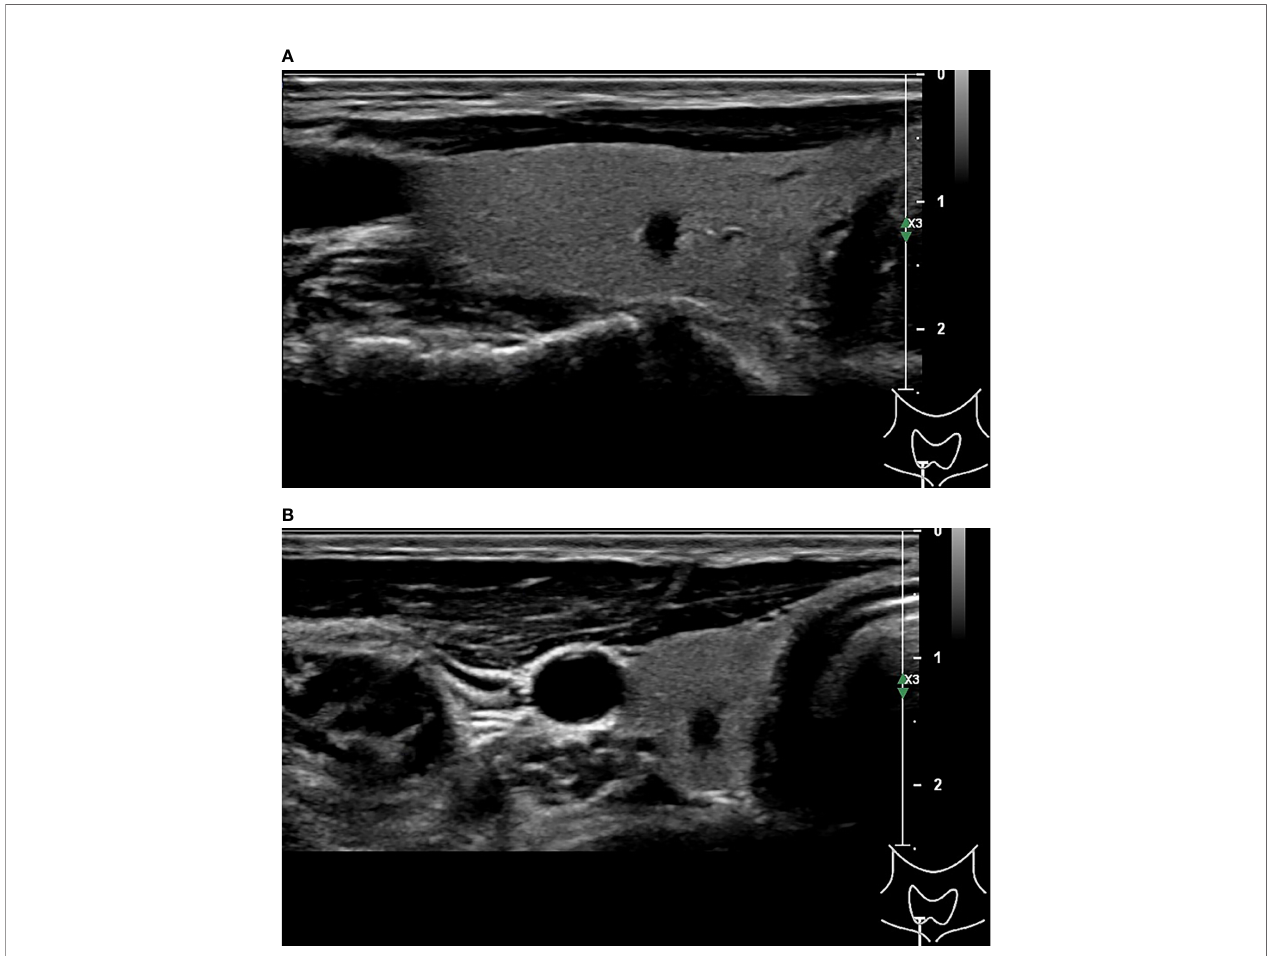
FIGURE 2 | 51-year-old man with thyroid papillary carcinoma. Sonographies of longitudinal scanning (A) and axial scanning (B) show the nodule locates at the right lobe of the thyroid, characterized by 4.9mm×3.3mm×3.5mm in size, solid composition, irregular shape, A>T orientation, markedly hypoechoic, well-de fi ned margin, and absence of posterior acoustic effect. C-TIRADS 4C, K-TIRADS 5, ACR-TIRADS 5. Histopathology con fi rmed it is a papillary